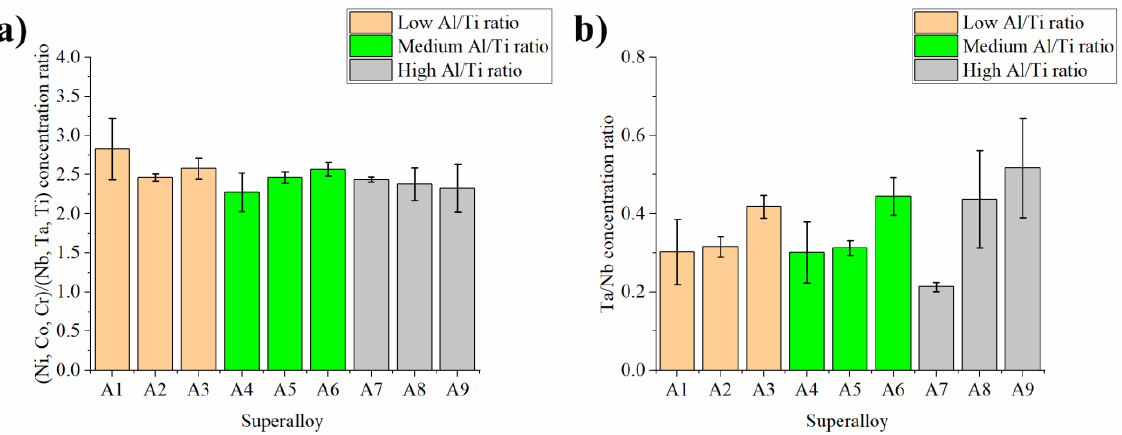
Figure 9. The atomic concentration relationship in the Laves phase precipitates in the interdendritic spaces: ( a ) (Ni, Co, Cr)/(Nb, Ta, Ti); ( b ) Ta/Nb, calculated based on semi-quantitative SEM-EDX measurements.